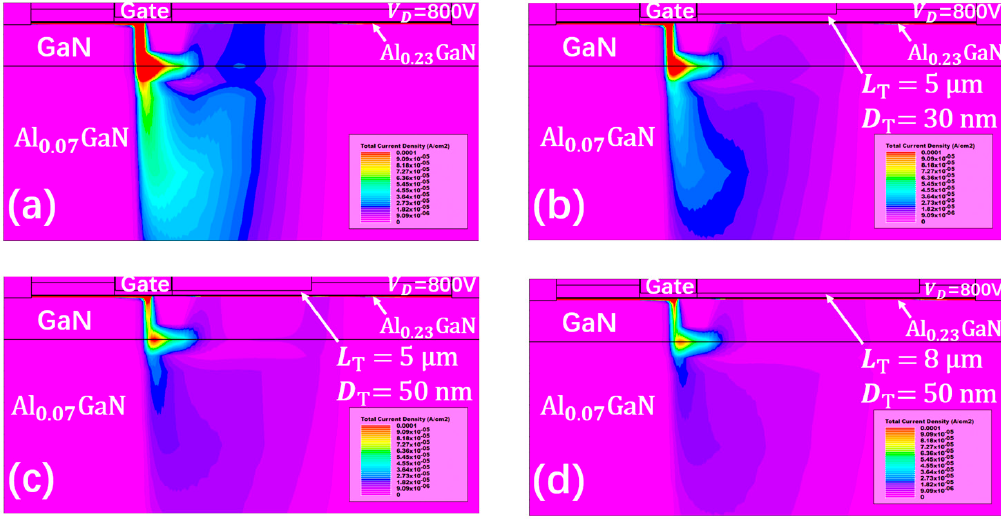
Figure Figure 9. The simulated current density distribution in ( a ) conventional UTB-HEMT, and ( b – d ) LCCT- HEMT with different LCCT configurations when the drain voltage is 800 V.